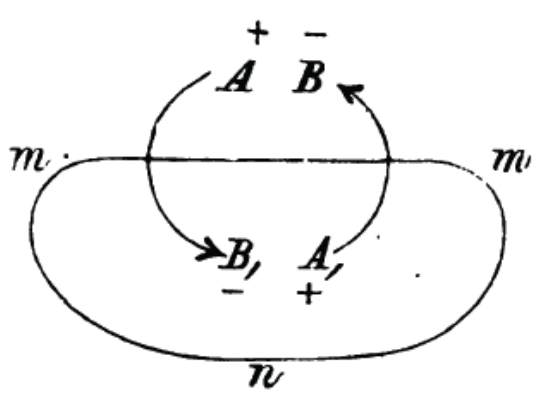
Figure 3. Schematic drawing of the flow of the circular current. For explanation, see main